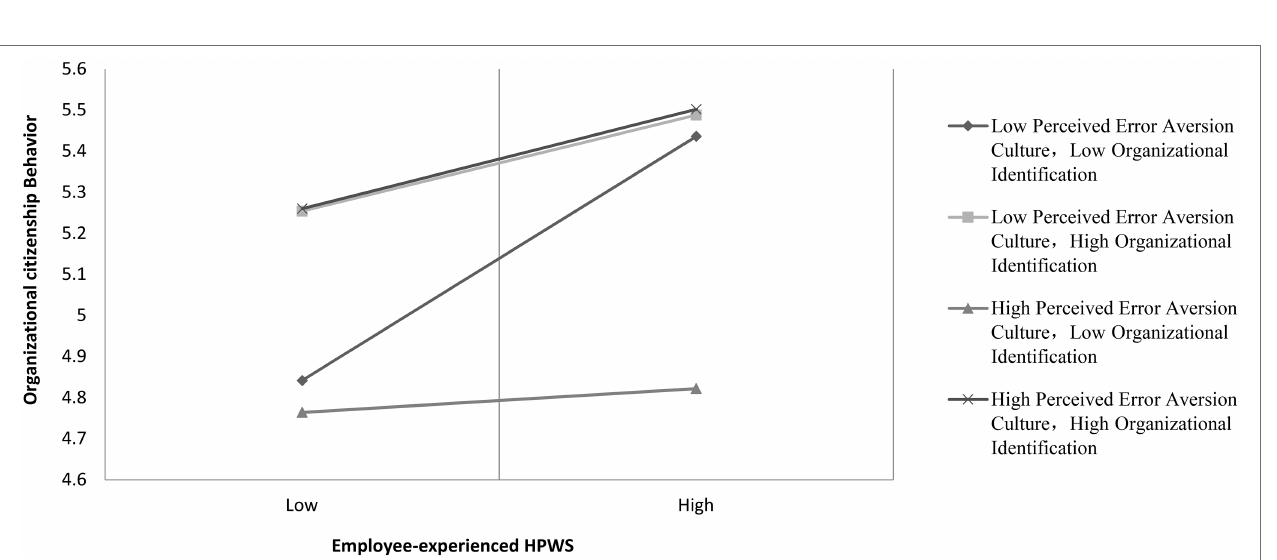
TABLE 5 | Simple slops test two-way and three-way interactions. Pairs of comparisons Slope Boot SE T test Bootstrap 95% Low perceived error aversion